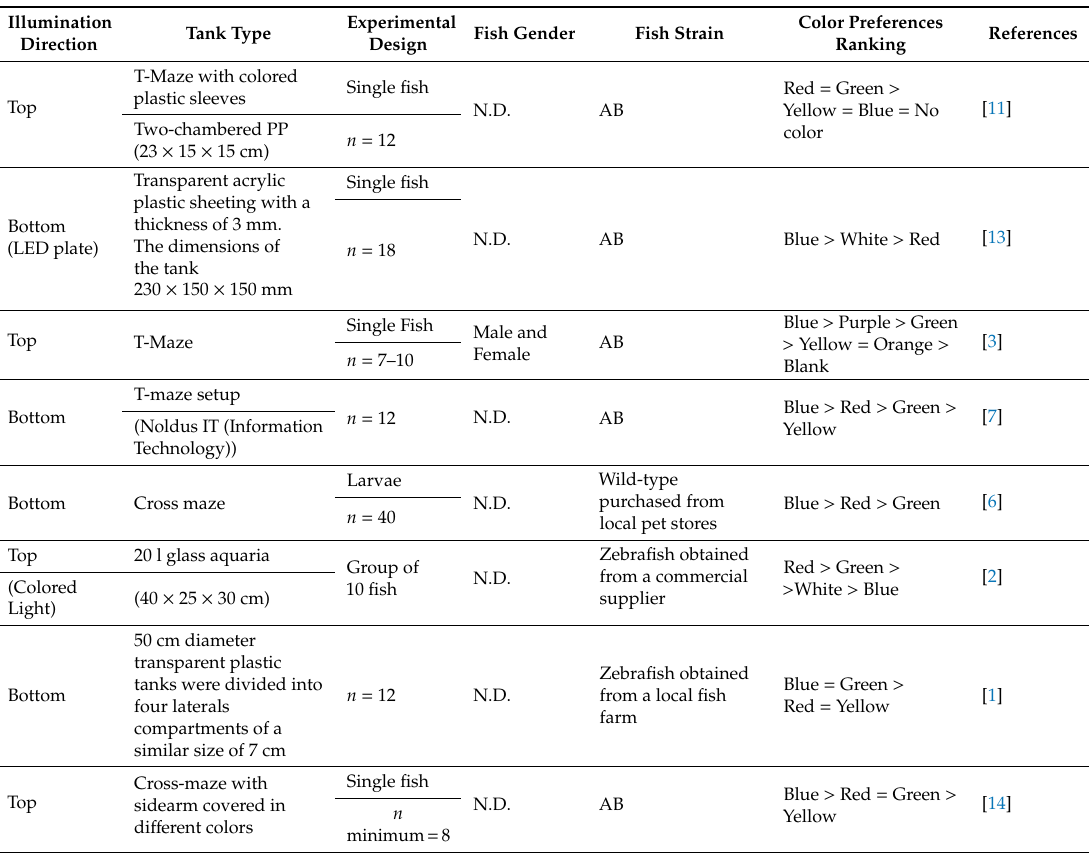
Table A3. Comparison of the conditions of the zebrafish innate color preference tests used in various